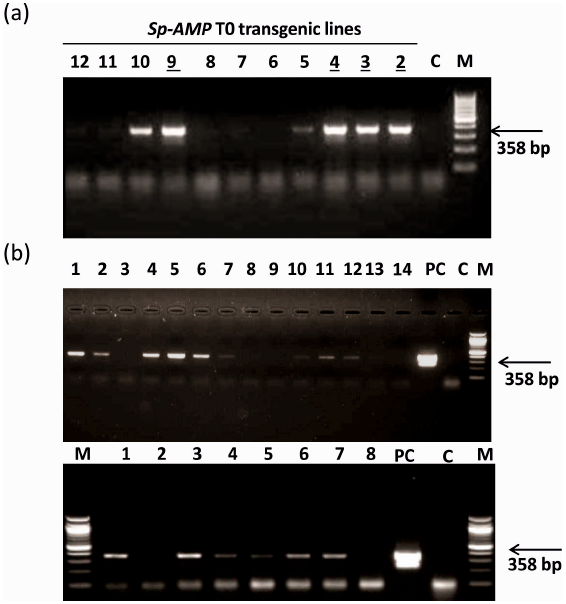
Figure 2. PCR analysis of DNA isolated from transgenic and control tobacco lines. ( a ) Fragment of 358 bp was generated from T0 plants using Sp-AMP2 -specific primers. Four lines were selected to generate T1 lines (underlined). Lanes 2–12: T0 transgenic tobacco lines; lane C: non-transformed tobacco (control); lane M: 100 bp DNA ladder. ( b ) Fragment of 358 bp was generated from T1 plant